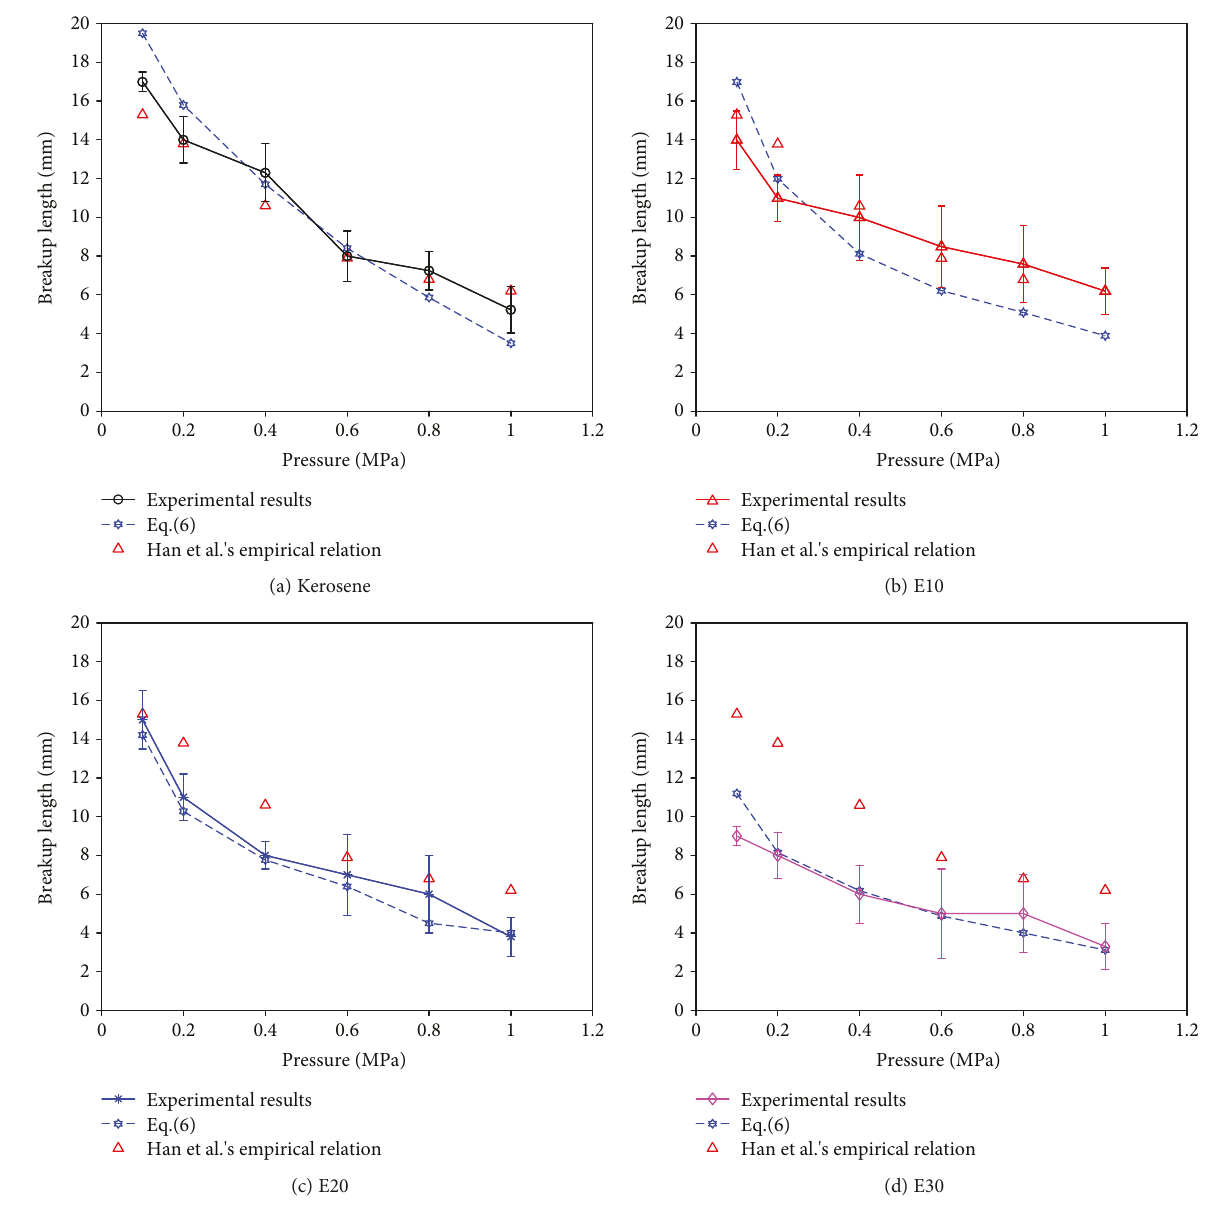
Figure 11: Variation of liquid breakup length with injection pressure.